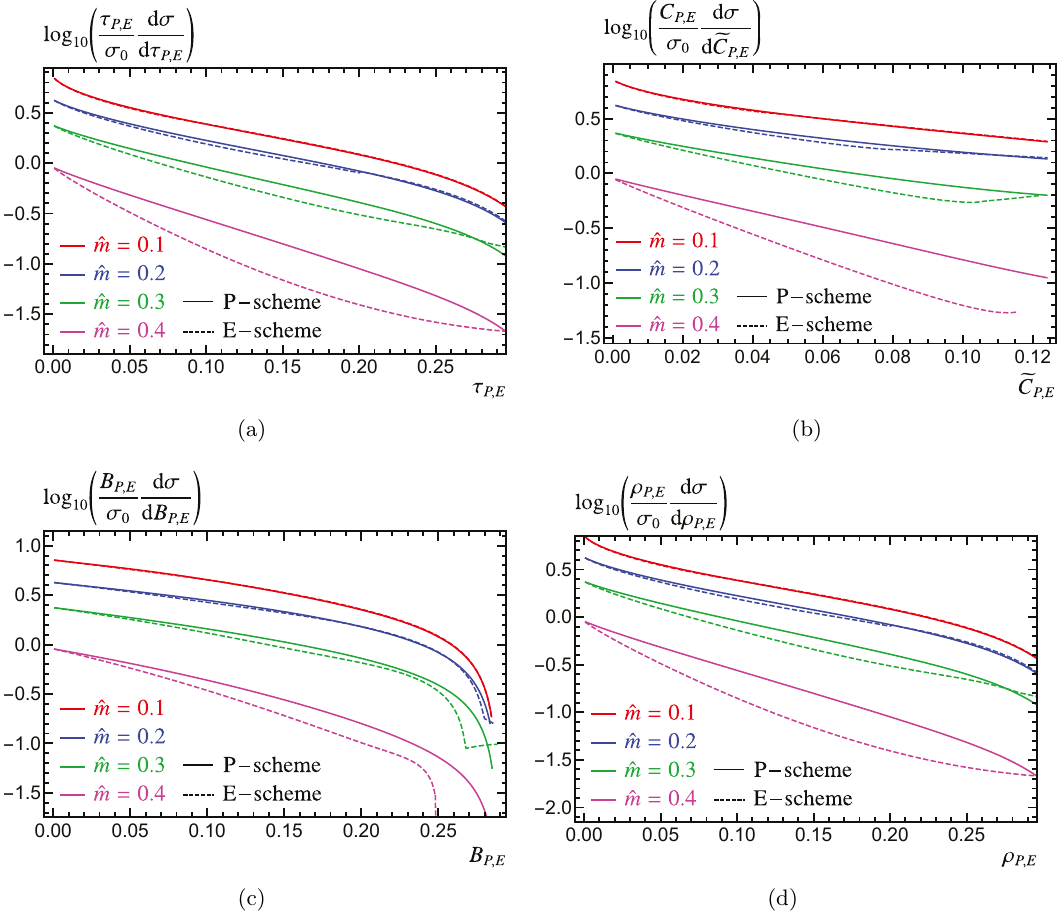
Figure 1 . Event-shape di(cid:11)erential distributions for the vector current in the P (solid lines) and E schemes (dashed lines). Panels (a), (b), (c), and (d) show the cross section for thrust, C-parameter, jet broadening, and heavy jet mass, respectively. All curves are multiplied by e (cid:0) e min , with e the event-shape value and e min its minimal value, such that the cross section is (cid:12)nite for e = e min . Red, blue, green and magenta show the results for ^ m = 0 : 1 ; 0 : 2 ; 0 : 3 and 0 : 4, respectively.